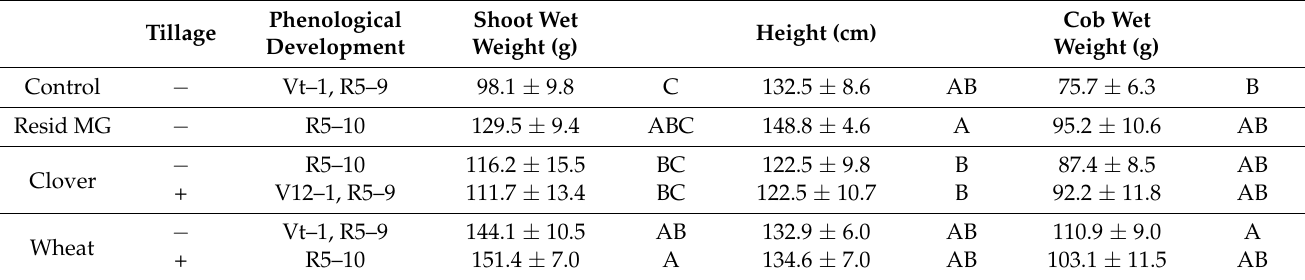
1 Values represent an average of 10 replications ± standard error. Statistically significant (one-way ANOVA, p < 0.05) differences between treatments at the same measures are indicated by different letters